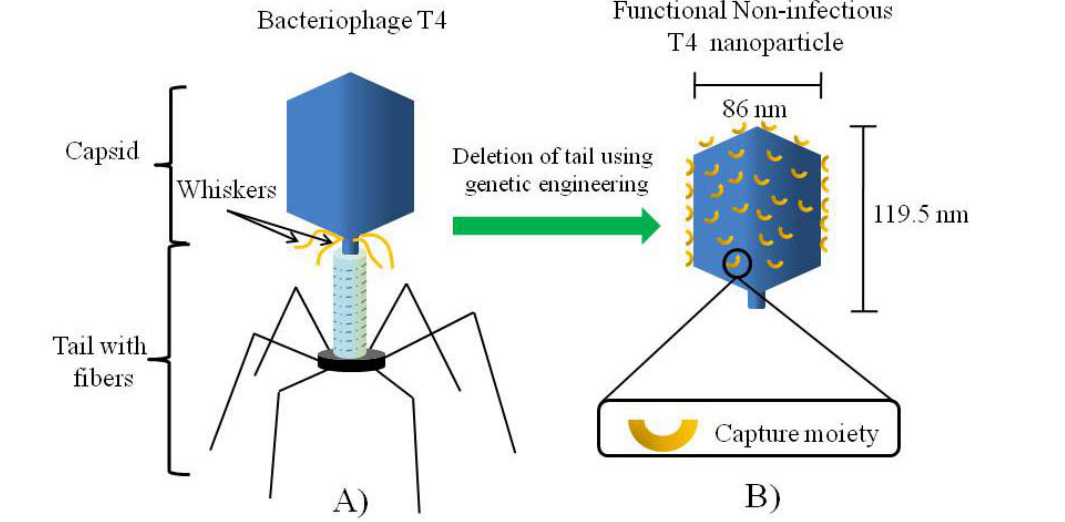
Figure 1. Schematic representation of A) bacteriophage T4 with all its native structures (capsid, tail, whiskers and tail fibers) and B) the non-infectious functional T4 nanoparticle decorated with a capture moiety resulting from genetic engineering of the wild type bacteriophage